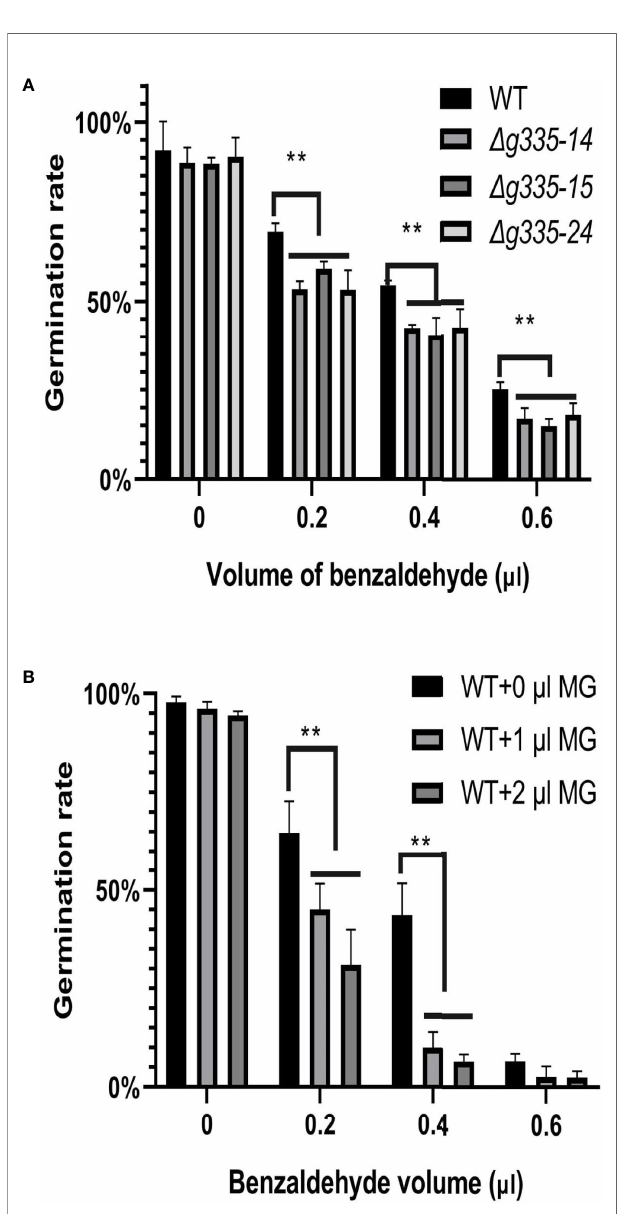
FIGURE 4 | Measurementof benzaldehyderesistance of mutant strains on WA medium. (A) Determination ofconidial germination rates (24 h) of mutant and wild-type strains onWAmedium containing different volume of benzaldehyde. (B) ExogenousMGincreased the fungistaticinhibition ofbenzaldehydeon conidial germination of wild-type strain.WT: wild-type strain. D g335-14 , D g335- 15 , and D g335-24 : AOL_s00004g335 knock-out mutants. **P <